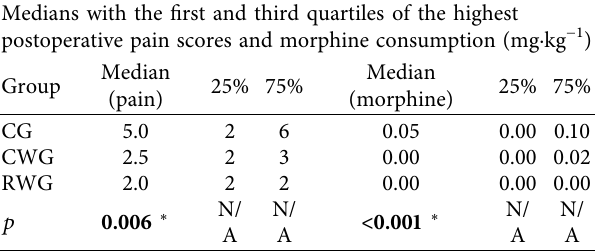
Table 3: Comparison of postoperative highest pain scores and morphine consumption during